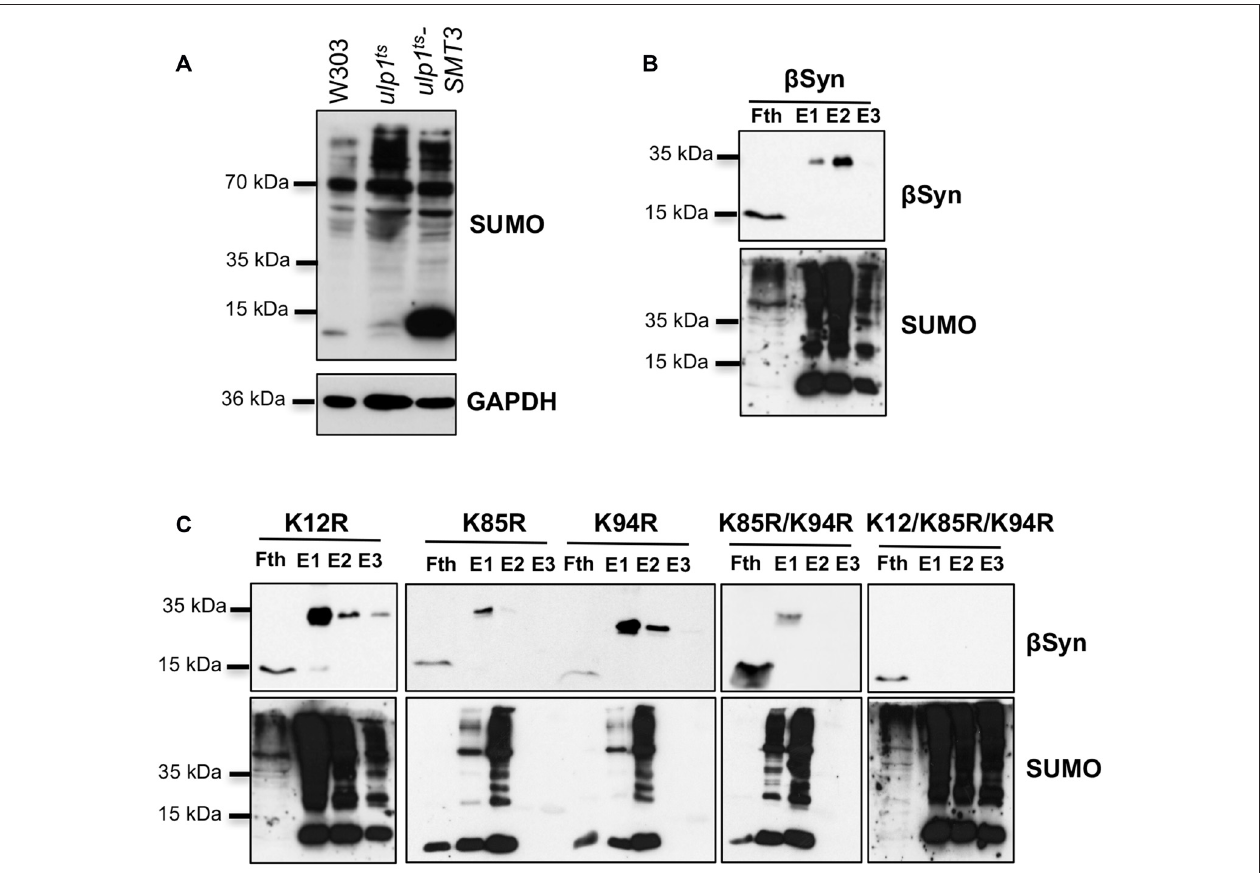
FIGURE 2 | β Syn is sumoylated in yeast. (A) Enrichment of sumoylated conjugates in ulp1 ts strain, expressing SMT3-HIS6 . Western blot analysis of the total protein extract from the ulp1 ts strain, deficient in SUMO-deconjugation, expressing His-tagged SMT3 . ulp1 ts and W303 were used as controls. SUMO-conjugated proteins were detected using specific SUMO antibody. GAPDH served as a loading control. (B) Ni 2 + pull-down of ulp1 ts -SMT3-His6 strain expressing GAL1 -driven β Syn. Fth: flow-through; E1: Elution 1; E2: Elution 2; E3: Elution 3. The same membrane was stripped and probed with SUMO antibody verifying the Ni 2 + pull-down. Modified β Syn migrates at ∼ 35 kDa. Unmodified β Syn migrates at ∼ 15 kDa. (C) Ni 2 + pull-down of ulp1 ts -SMT3-His6 strain expressing β Syn sumoylation deficient mutants K12R, K85R, K94R, K85R/K94R and